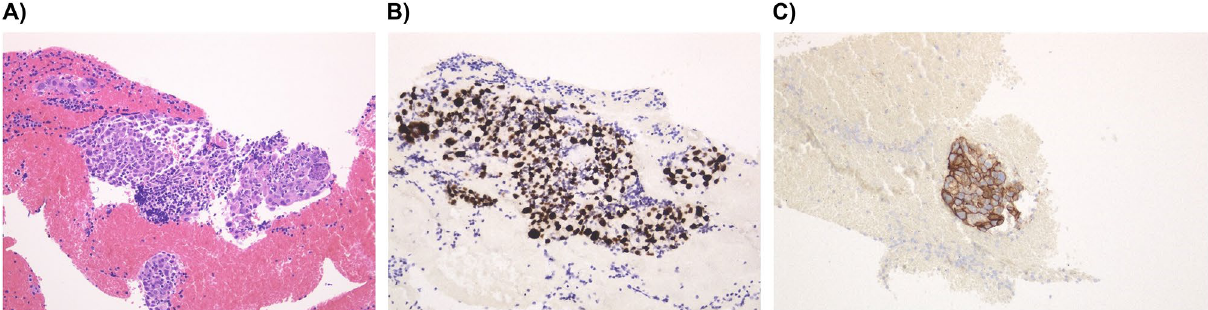
Figure 3. Pathological examination of one case of adenocarcinoma. ( A ) Hematoxylin–eosin staining. ( B ) Thyroid transcription factor-1 (TTF-1) staining using TTF-1 antibody. C) PD-L1 staining using PD-L1 IHC 22C3 PharmDx assay.